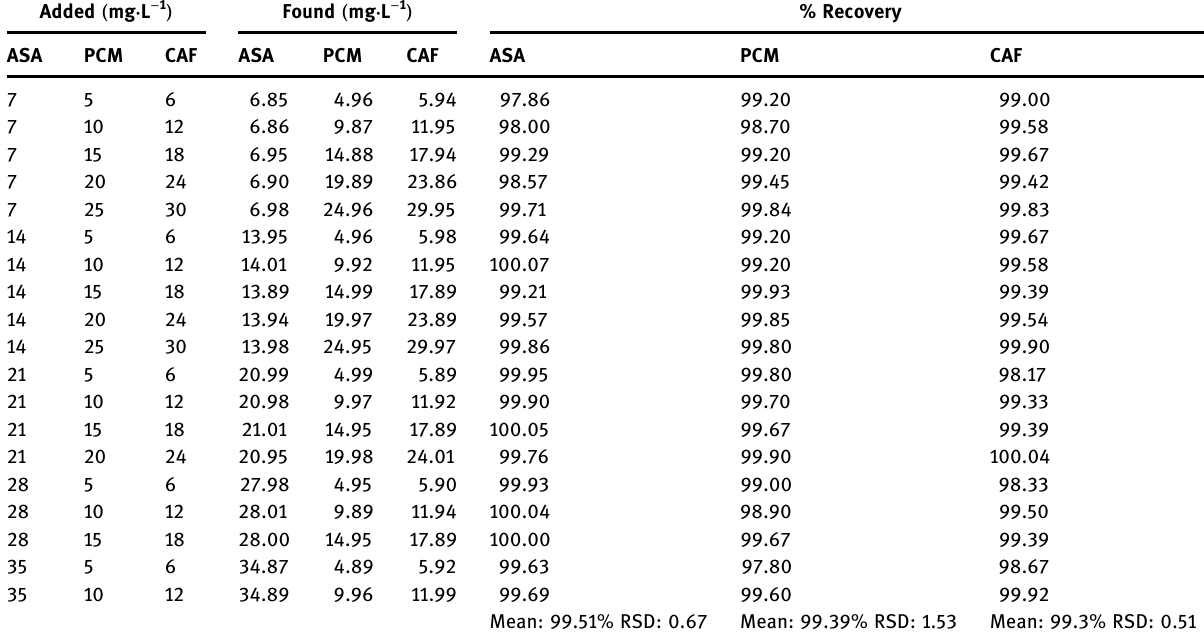
Table 4: For the PCR approach, the composition of the prediction set and the recovery outcomes obtained in synthetic mixtures Added ( mg · L − 1